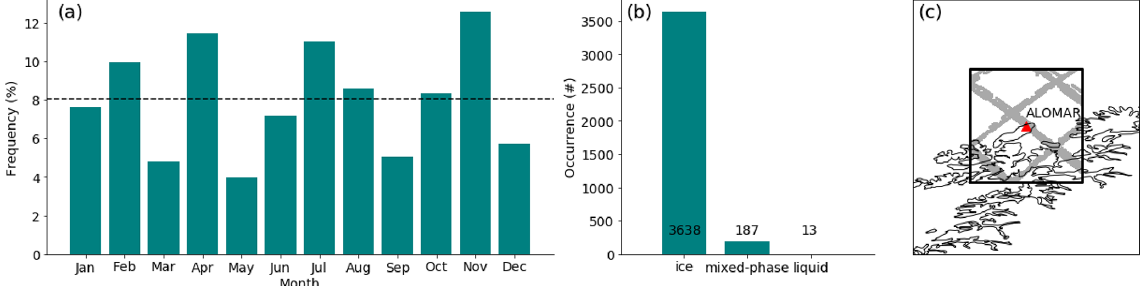
Figure 5. (a) Monthly single-layer cold-cloud occurrence from satellite. (b) The distribution of cloud phase, given as the number of observed single-layer cold clouds. (c) The spatial box from which cloud measurements are taken for the analysis: the ground-based lidar at ALOMAR is indicated by the red triangle, the box extends 2 ◦ around ALOMAR (1 ◦ in each direction), and satellite overpasses with cloud detection are indicated in gray.